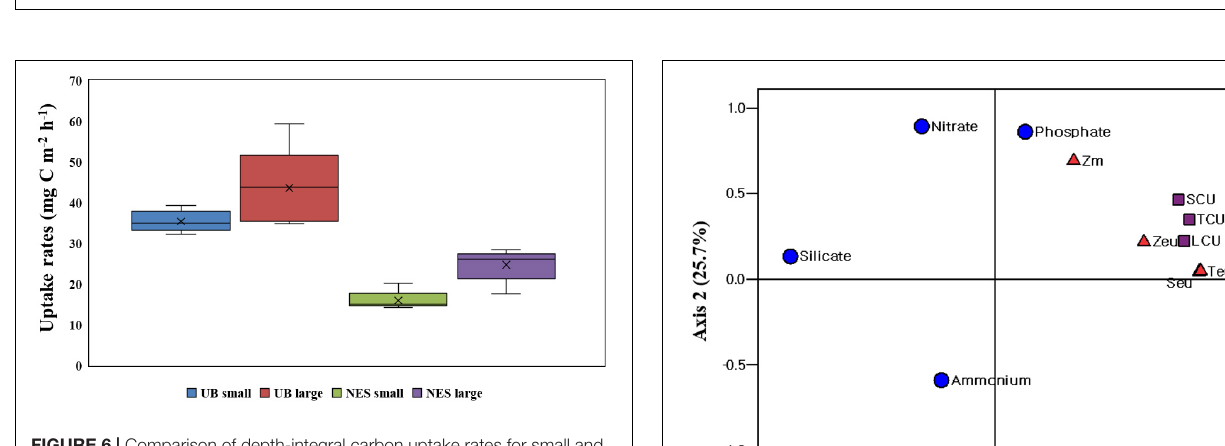
FIGURE 5 | Spatial distributions of (A) chl a concentration and (B) hourly carbon uptake rates for small and large size phytoplankton integrated within the euphotic depths from 100 to 1% light depth at the productivity stations in 2016.